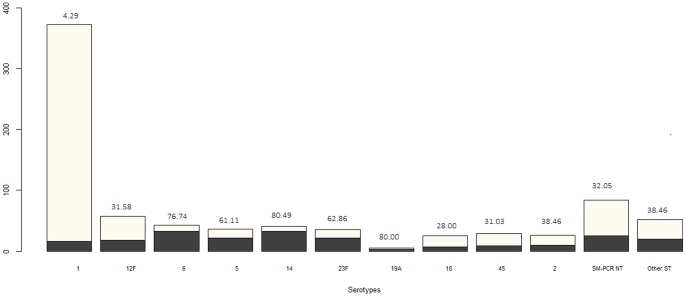
Number of PM cases in under 2 year olds (black) and over (grey) 2 years old for the prevalent serotypes.Percentages of cases in children <2 years are given over the bar plots.